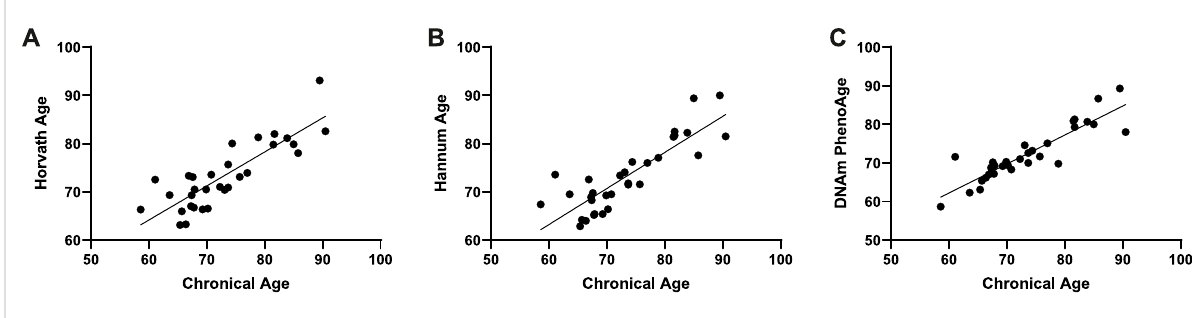
FIGURE 1 Correlation between epigenetic age and chronological age.